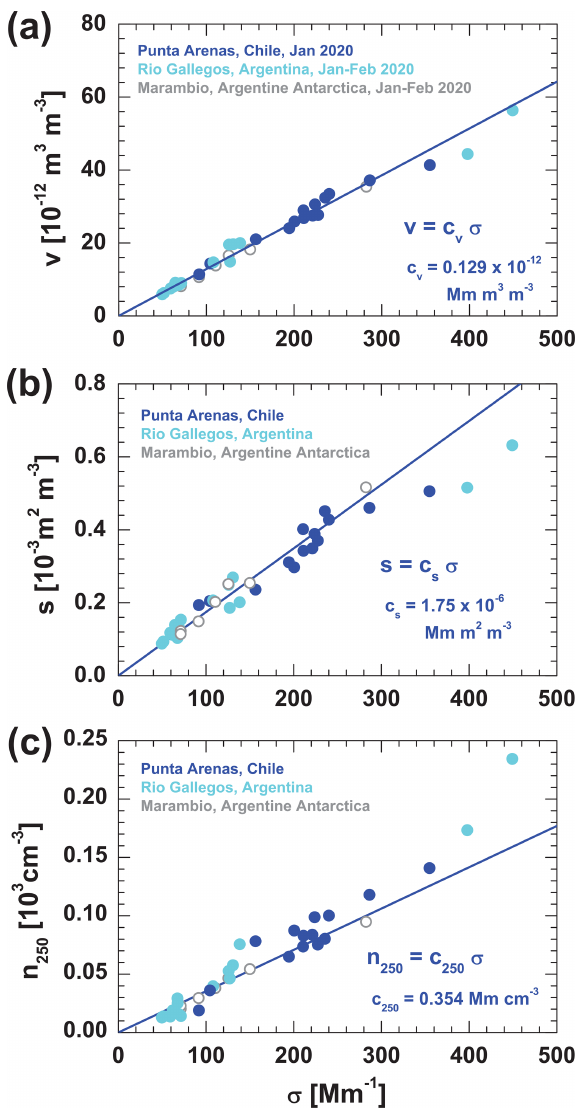
Figure 6. Relationship between smoke extinction coefficient σ (532nm) and (a) volume concentration v , (b) surface area concen- tration s , and (c) number concentration n 250 of aged stratospheric Australian smoke observed over the three AERONET stations in South America and Antarctica. The slopes are defined by the equa- tions in the different panels (a) , (b) , and (c) . The conversion factors c v , c s , and c 250 in these equations are the mean values of the ob- served individual ratios of v/σ (Eq. 19), s/σ (Eq. 21), and n 250 /σ (Eq. 20). These mean values are given as numbers in the panels and together with the corresponding standard deviations also in Table 3.